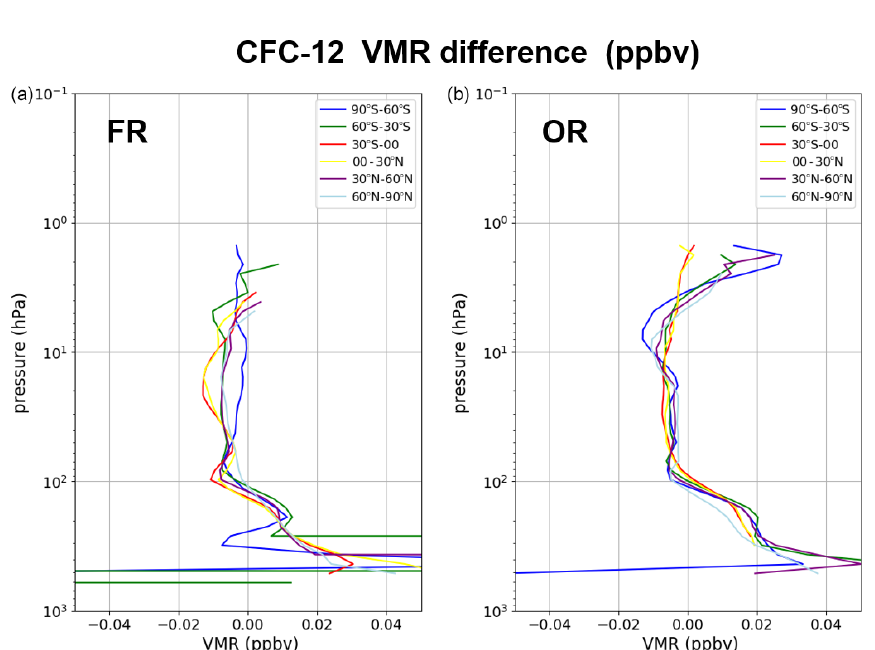
Figure 14. Same as Fig. 10, but for the CCl 4 profiles.